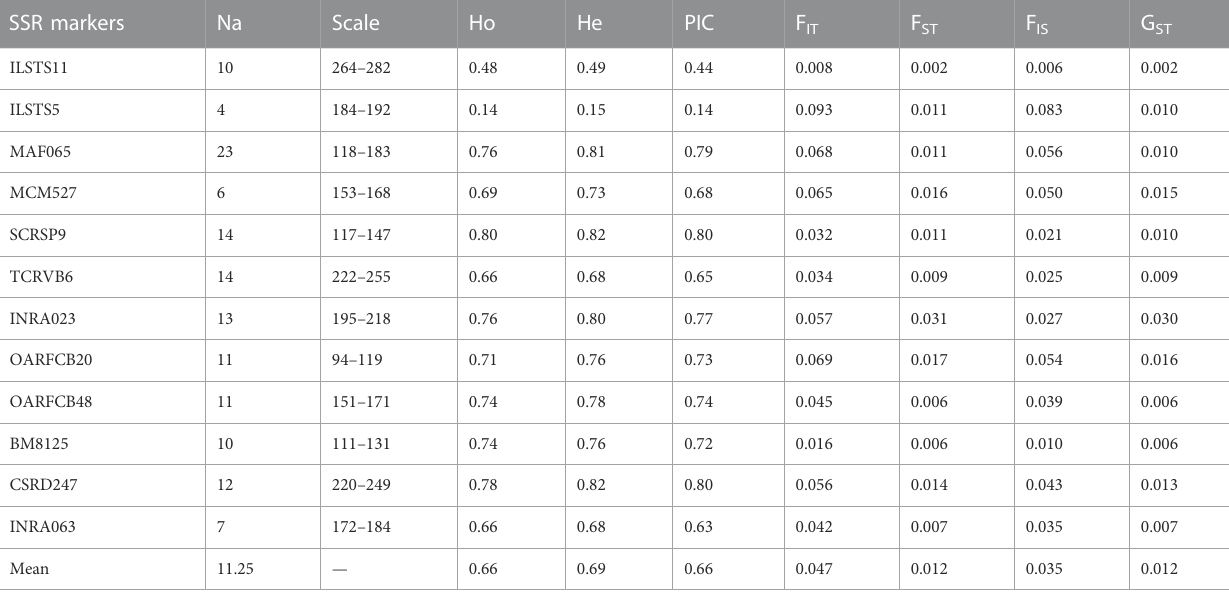
TABLE 1 Genetic diversity indices calculated for 12 SSR markers in 954 goat datasets sampled in the three vegetation zones of Benin. SSR markers Na Scale Ho He PIC F IT F ST F IS G ST